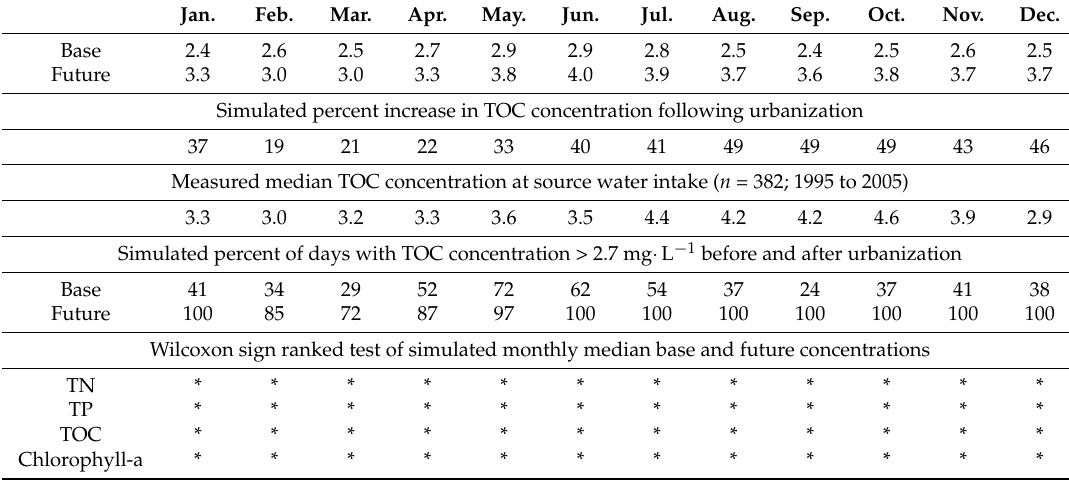
Table 5. Monthly median base, future and measured ( n = 382) total organic carbon (TOC) concentration (mg ¨ L ´ 1 ) and monthly TOC percent increase in concentration and percent of days with TOC concentration >2.7 mg ¨ L ´ 1 before and following urbanization at the drinking water intake on Converse Reservoir, AL, 1992 to 2005.